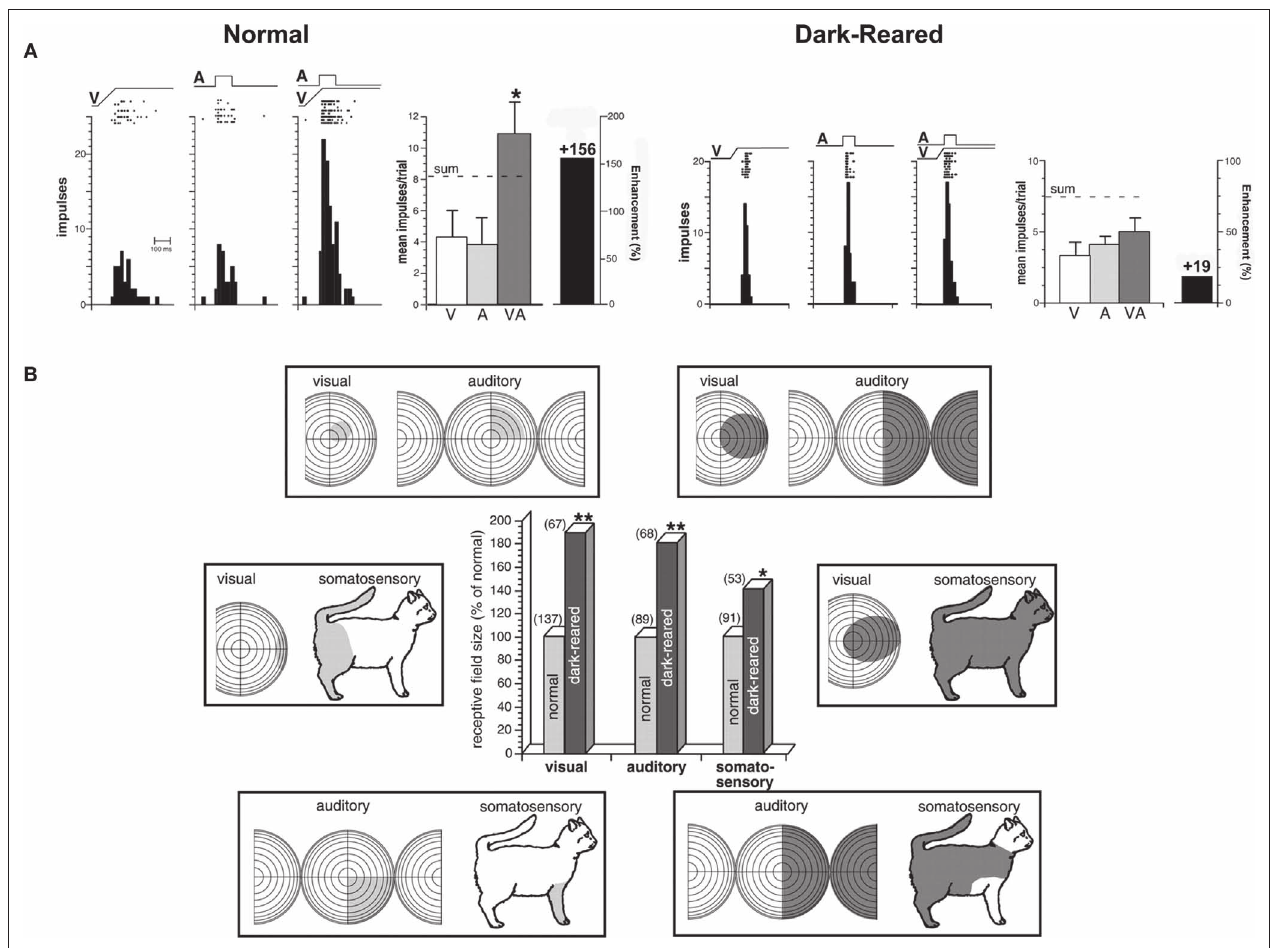
dark-reared animals were signifi cantly larger than those in control animals. Receptive fi elds (shading) are shown for three representative multisensory neurons in control (left) and dark-reared (right) animals. Conventions are the same as in Figure 2 . The central bar graph plots the relative sizes for the visual, auditory, and somatosensory receptive fi elds of multisensory neurons in the SC of normal (gray bars) and dark-reared (black bars) animals. Note that these mean measures are standardized to receptive fi eld sizes in normal adults (100%). Values in parentheses represent the number of neurons in each group. * p < 0.05; ** p < 0.01. Adapted from Wallace et al.